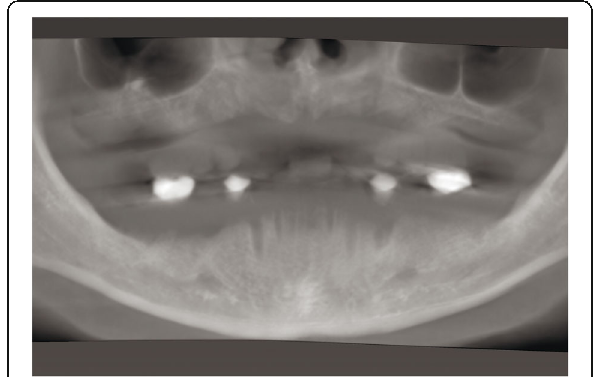
Fig. 1 Pre-operative CBCT with radiographic template